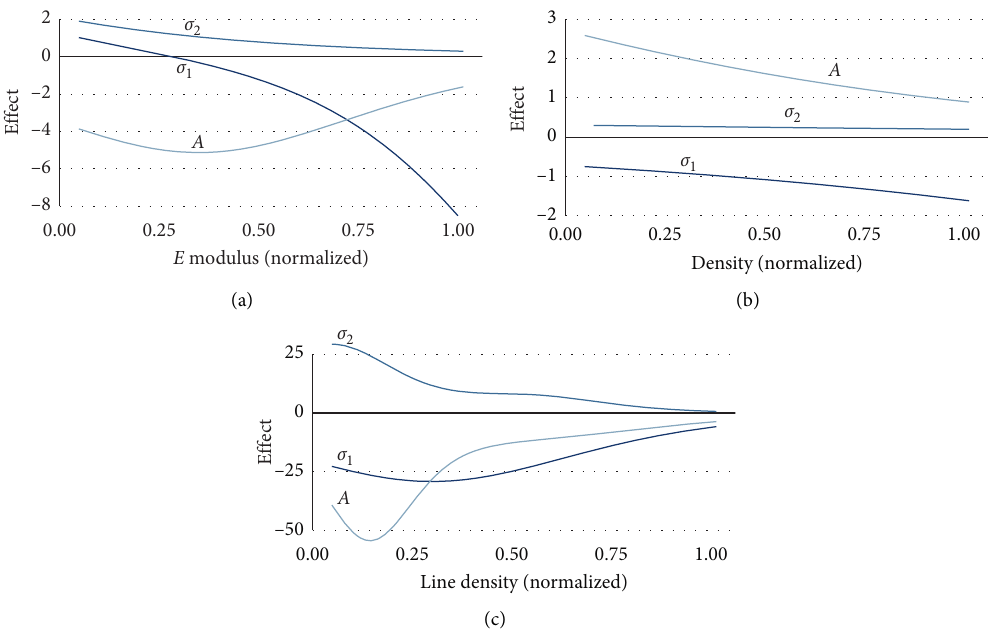
Figure 10: Effect of the input process parameters on the fiber laydown characteristics: the pressure effect (a) is with 0 for σ 0.005 for A negligible. The effect on the air speed onto the fiber laydown characteristics (b) is with a range of 0.01 to 0.07 ten times bigger than the influence of the pressure.